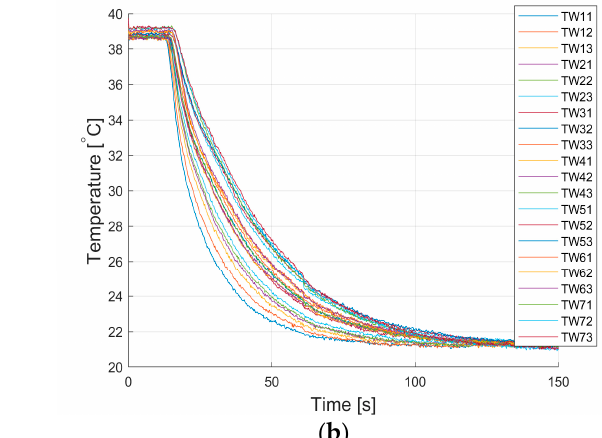
Figure 7. Scheme for implementation of the measurement experiment.